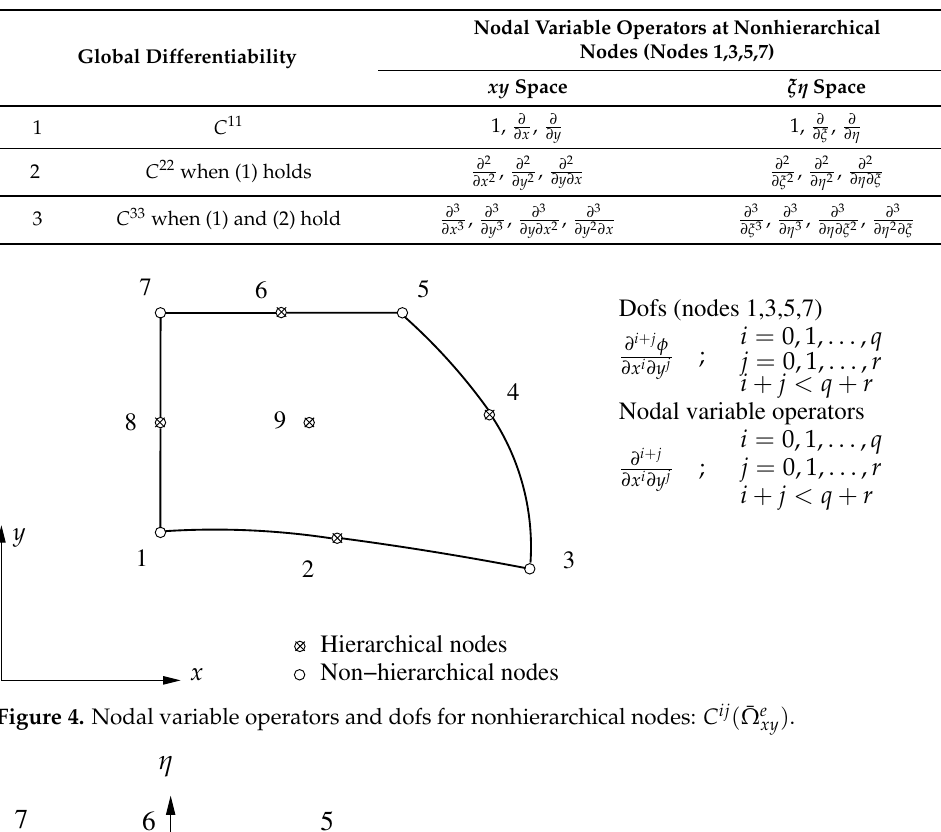
Table 1. Nodal variable operators at the nonhierarchical nodes for C 11 , C 22 , C 33 classes in xy and ξη spaces.